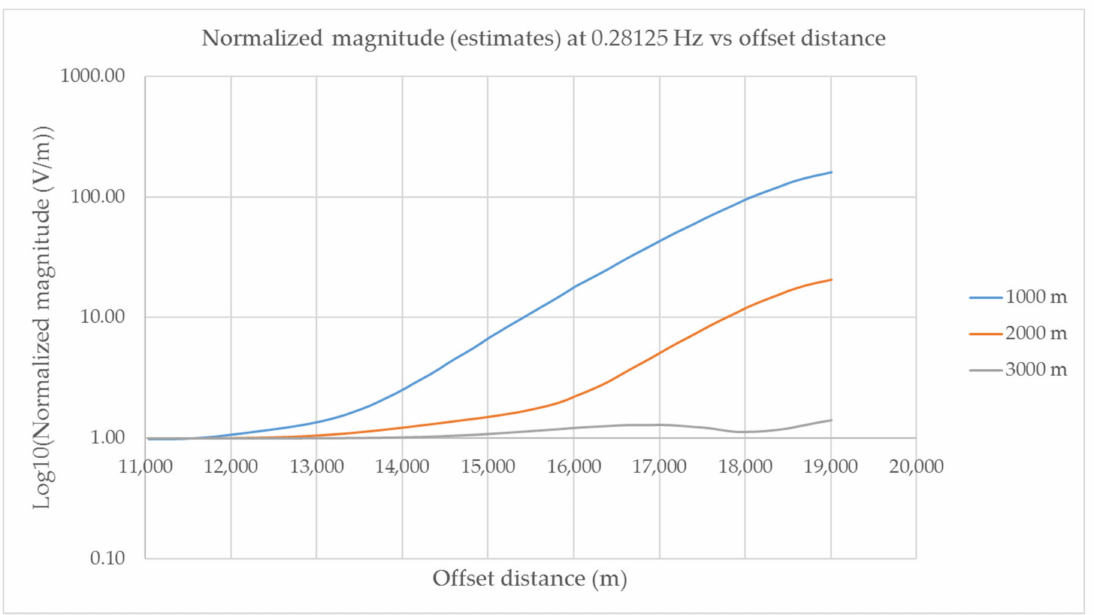
Figure 14. Normalized MVO responses for transmission frequency of 0.28125 Hz: (i) normalized MVO for a hydrocarbon depth of 1000 m (blue); (ii) normalized MVO for a hydrocarbon depth of 2000 m (reddish-yellow); (iii) normalized MVO for a hydrocarbon depth of 3000 m